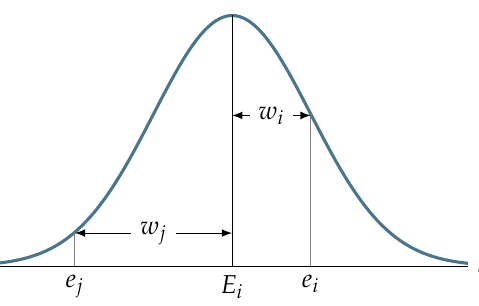
Figure 12. Illustration of edges weighting